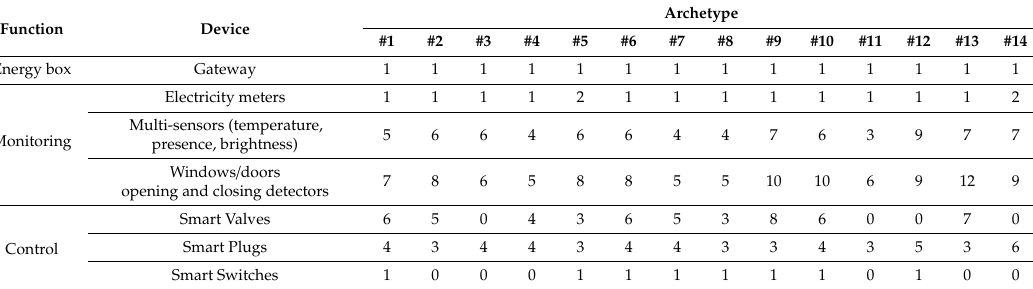
Table 4. Control kits configuration for the archetypes.